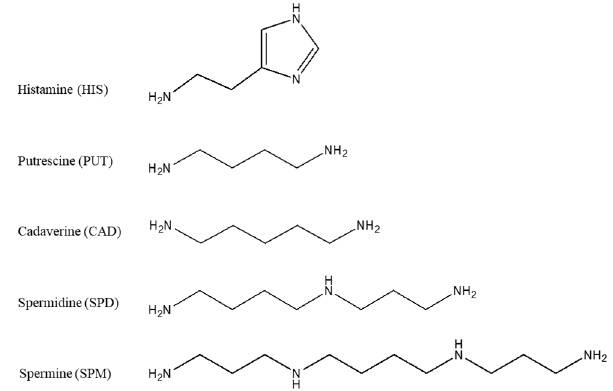
Figure 1. Molecular structures of the biogenic polyamines.